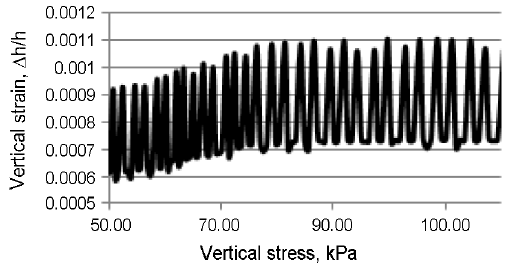
Fig. 15. Vertical stress versus vertical strain (rubber compres- sion from 50.0 to 120.0